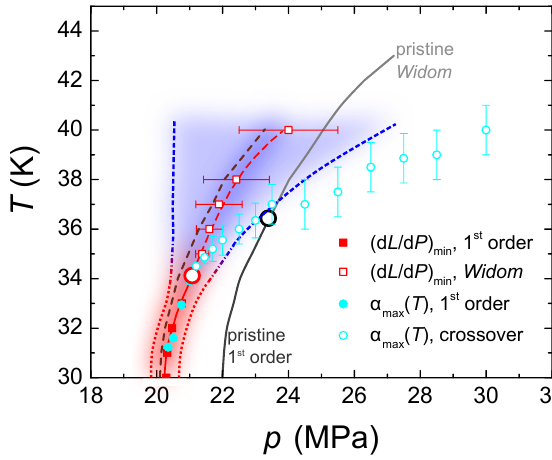
Figure 3. Experimentally determined temperature-pressure phase diagram of κ -(BEDT-TTF) 2 Cu[N(CN) 2 ]Cl (batch #AF063) after exposure to X-ray for 50h. Red full squares correspond to the first-order Mott transition line extracted from the inflection point of ∆ L b ( p ) / L b . Cyan full circles correspond to the first-order transition line extracted from temperature-dependent measurements. The latter data points were determined by the position of the maximum α max of the thermal expansion coefficient α b ( T ) = L − 1 d L b /d T for p < p c . Red open symbols correspond to the Widom line. Open cyan b symbols correspond to a crossover line, determined by the position of α max for p > p c . Red- and blue-shaded areas delimited by the broken lines in the same color code indicate the experimentally determined width of the features along the b axis and can be assigned to the disorder-related (red) and the criticality-related (blue) crossover regimes, respectively. The broken lines represent, within the error margins, the full width at half maximum of the peaks in d L /d P . The brown dashed line corresponds to the p c ( T ) curve extracted from a fit of the data, presented in Figure1 to the mean-field model of Equation(1) (see text for details). The first-order transition line (dark grey line), the Widom line (light grey line) and the critical endpoint (black open circle) for a pristine crystal of batch #AF063 [25] are given for